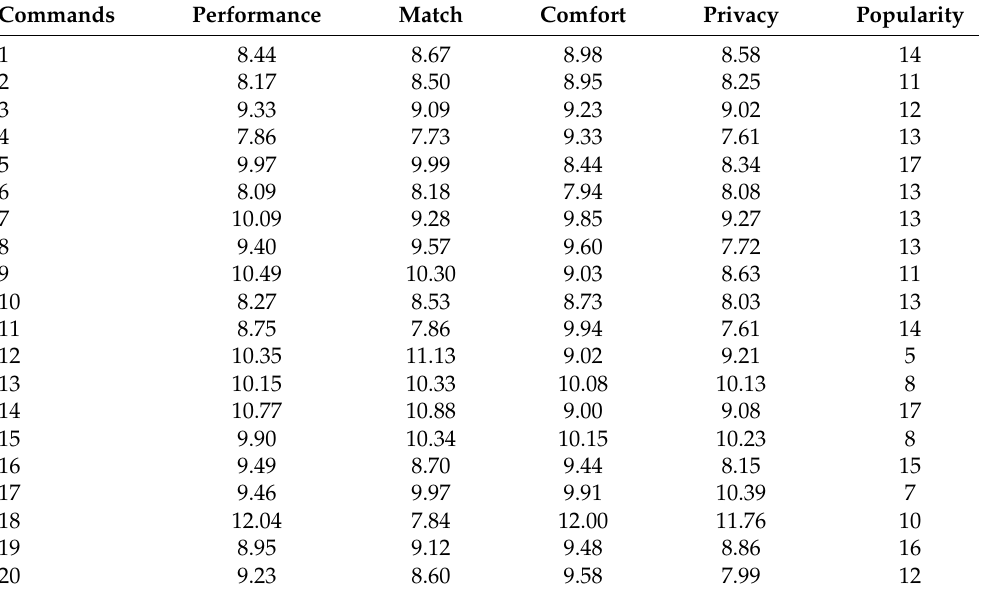
Table A1. The ratings and popularity of the proposed microgesture set among participants from the US and Europe ( n = 18).